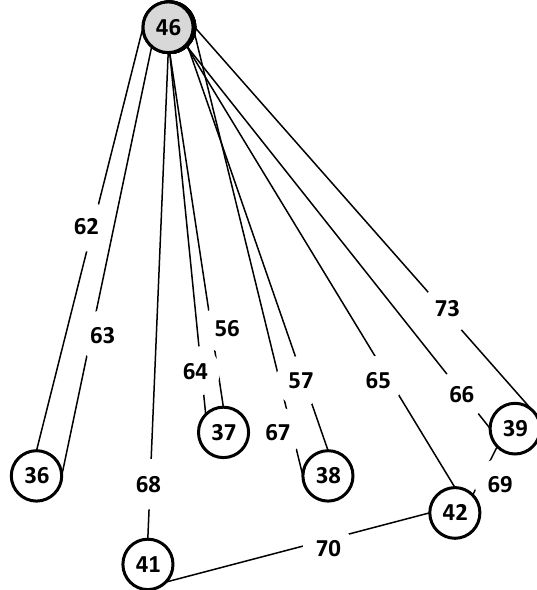
Figure 7. Folded graph with a highlighted cluster at the 4 th level